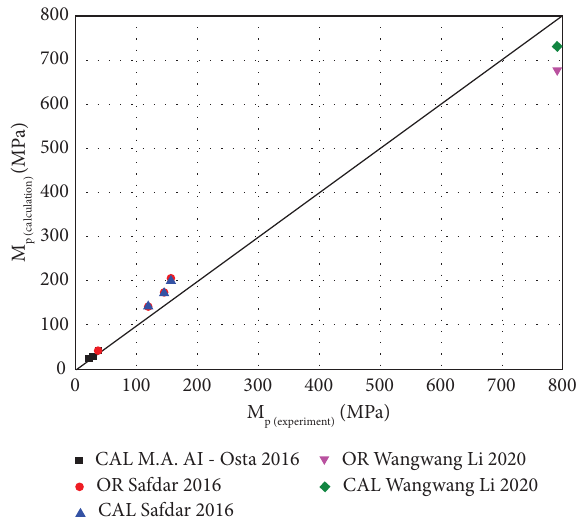
Figure 13: Experimental peak loads versus the corresponding literature sure peak load and the current calculated peak load.